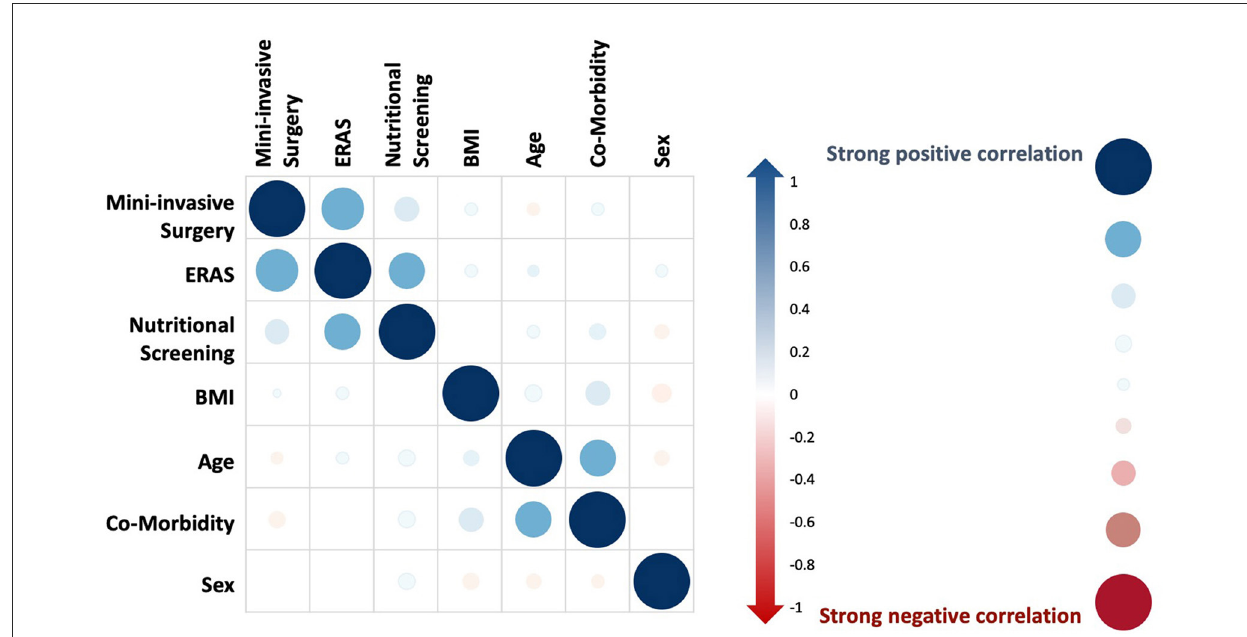
ERAS Nutritional